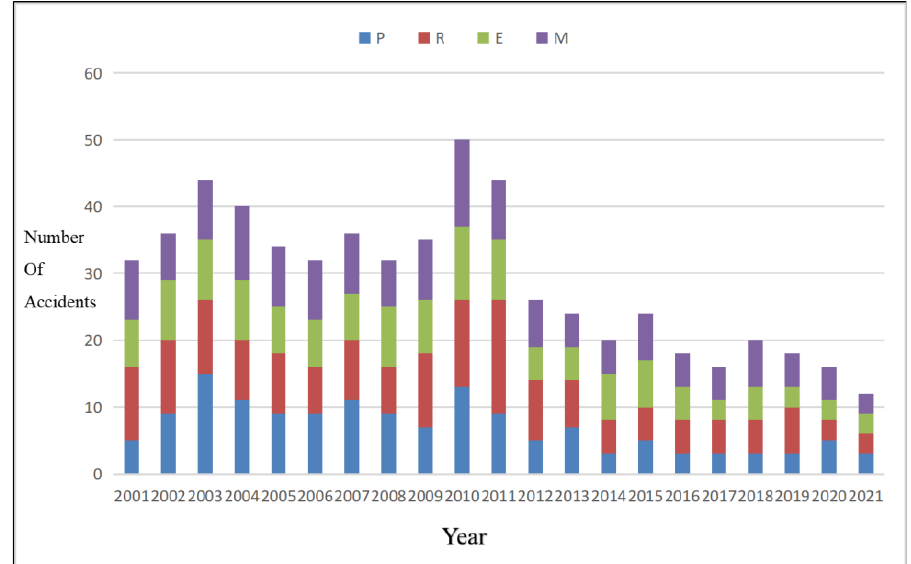
Figure 2. Statistics of traditional ship accidents caused by corresponding risk factors. Table 2. Statistics of autonomous ship navigation accidents. Factor i